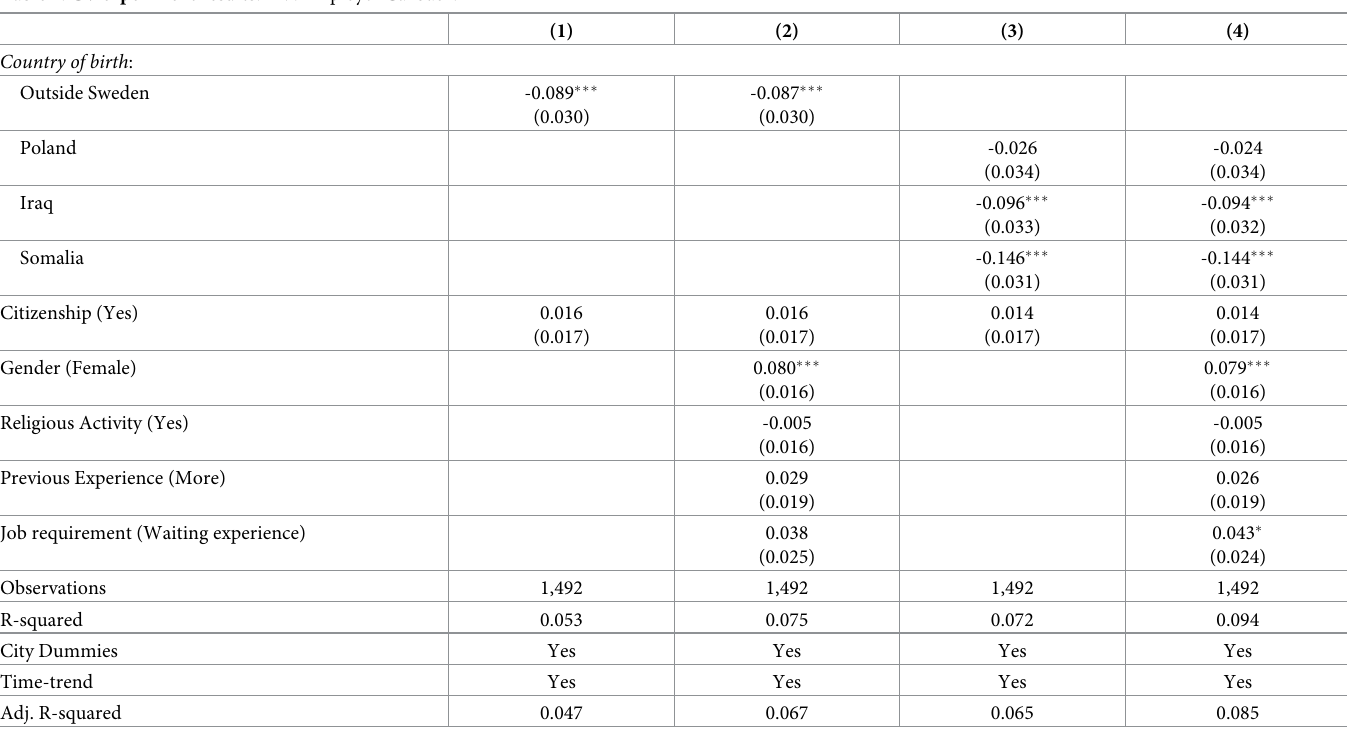
Table 2. CV experiment results. DV: Employer